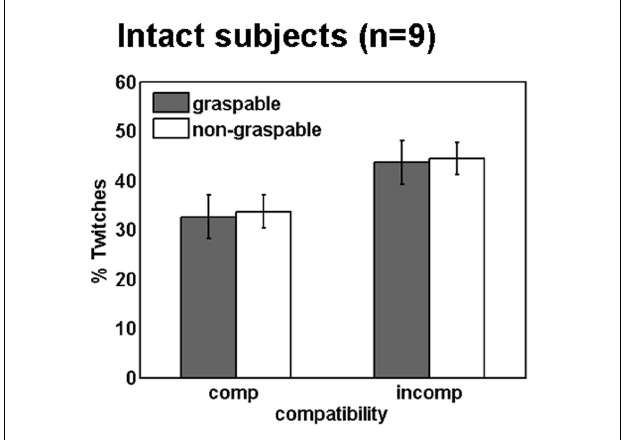
FIGURE 4 | Spatial compatibility effects during movement preparation in intact participants. Mean percentage of twitches (i.e., EMG activity in the hand irrelevant for response, see methods) in intact subjects. Annotations are as in Figure 3